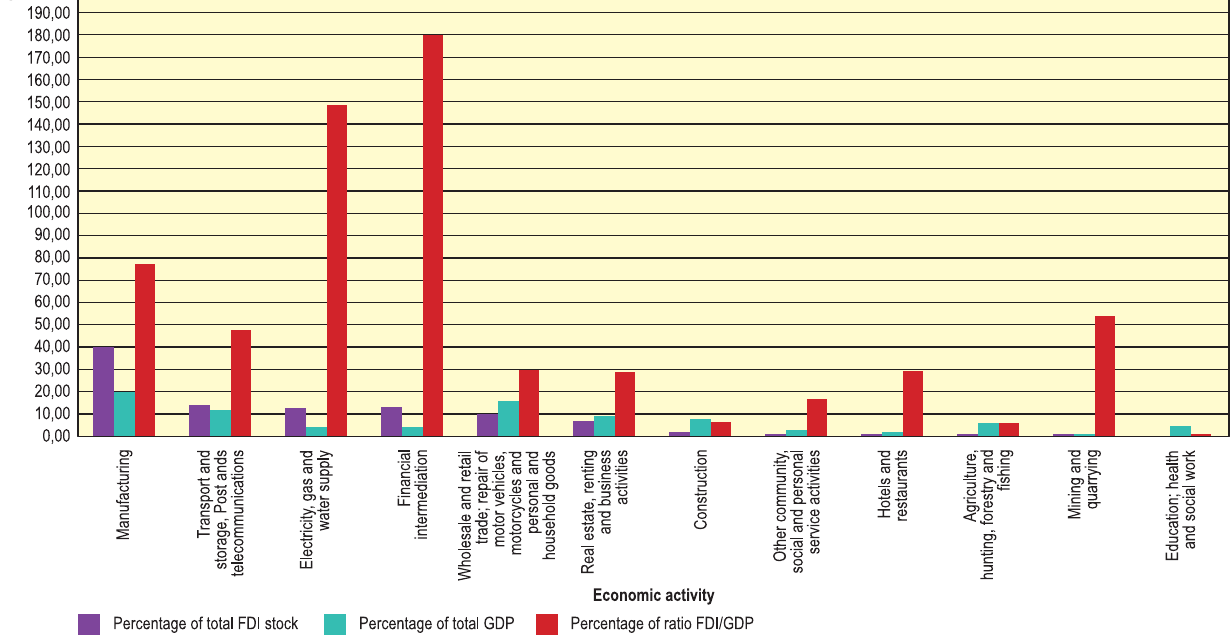
Fig. 1. Juxtaposition of data on FDI stock, GDP and FDI/GDP ratio in Lithuania in the year